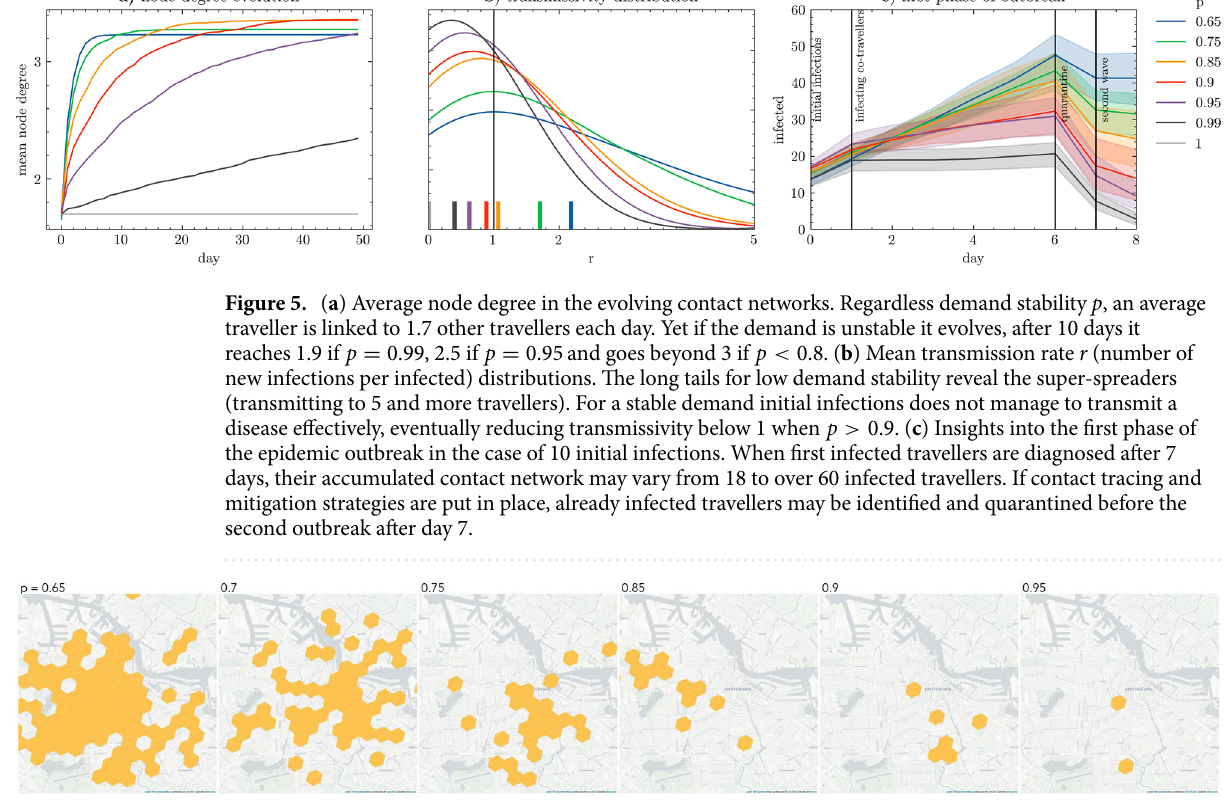
Figure 6. An illustration of the spatial extent of epidemic outbreaks originating from two initial infections. A major part of Amsterdam becomes infected for spontaneous demand (left), while it remains spatially contained as the demand stabilises (right). For stable demand ( p > 0.8 ) the geographical boundaries are confined, while otherwise, the virus crosses the river Ij and reaches also the north parts of